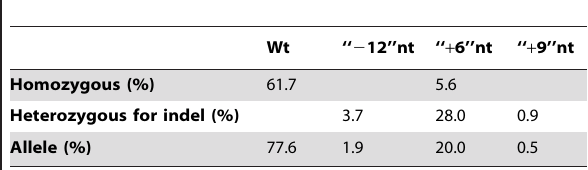
Table 4. Overall frequencies of sheep SPRN Indel